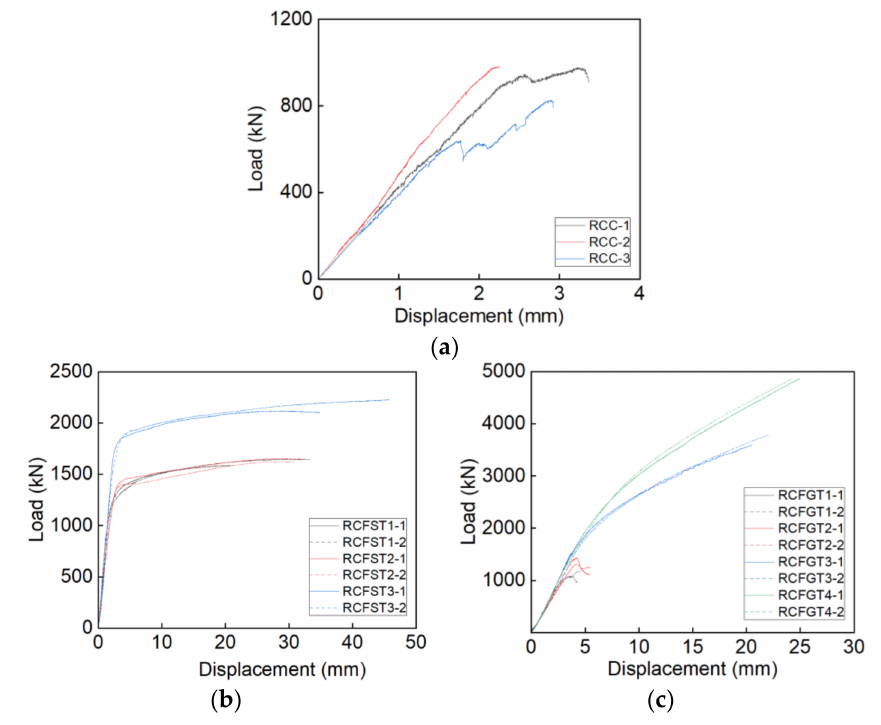
Figure 11. The load-displacement curves. ( a ) RCC; ( b ) RCFST; ( c )